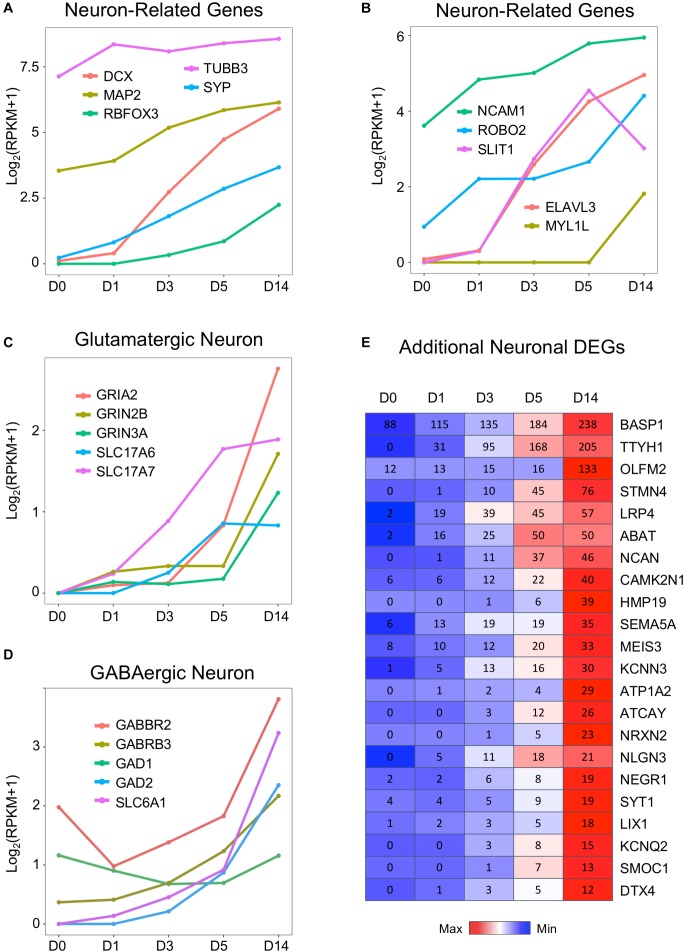
Neuronal genes were activated by the core drugs and highly expressed in D14 samples. (A) Typical neuronal marker genes such as doublecortin (DCX), RBFOX3 (NeuN), MAP2, and synaptophysin (SYP) were highly upregulated upon the application of small molecules. Note that DCX increased much faster than NeuN. Interestingly, βIII-tubulin (TUBB3, often labeled with TUJ1 antibody) was highly expressed in HAs and only modestly increased during chemical treatment. (B) Neuronal cell adhesion molecules (NCAM1) and chemoattractant/chemorepellent genes (SLIT1/ROBO2) were upregulated by small molecule treatment. (C) Dramatic increase of glutamatergic neuron–related genes, including subunits of AMPA receptors (GRIA) and NMDA receptors (GRIN), as well as vesicular glutamate transporters (SLC17A6 = VGLUT2; SLC17A7 = VGLUT1). (D) Expression profile of GABAergic neuron–related genes, including GABA receptor subunits, glutamate decarboxylases, and GABA transporters. GABBR2 = GABA type B receptor subunit 2. GABRB3 = GABA type A receptor subunit β3. GAD1 = GAD67. GAD2 = GAD65. SLC6A1 = GAT1. (E) Heat map of representative genes that were highly upregulated in D14 samples after core drug treatment. Color scaled within each row and FPKM values presented.